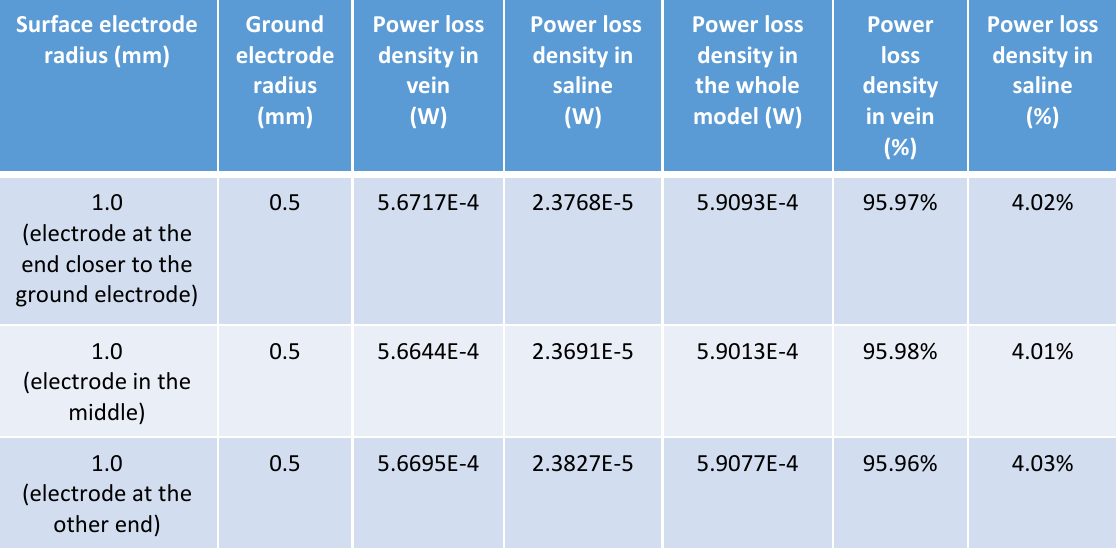
Table.10: Volumetric power loss density measurement at 1MHz with one of the 32 surface electrodes as terminal (8 electrodes in 4